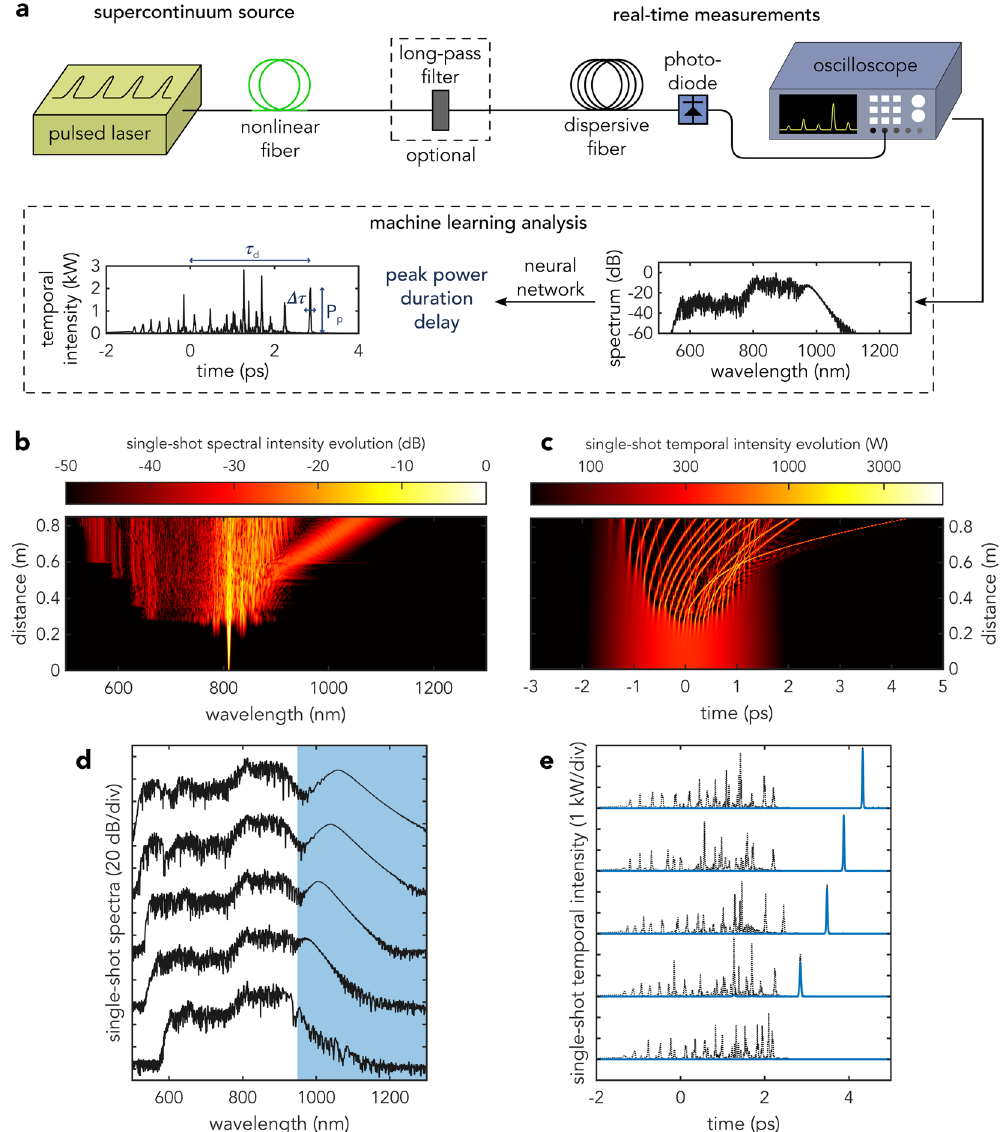
Figure 1. ( a ) Schematic of machine learning application to the analysis and prediction of rogue soliton temporal characteristics in supercontinuum generation based only on single-shot spectral measurements. ( b – e ) Dynamics of noisy supercontinuum generation. Single-shot spectral ( b ) and temporal ( c ) evolution where we see enhanced spectral broadening associated with the emergence of a rogue soliton. ( d , e ) show a selection of 5 random supercontinuum spectra and corresponding temporal intensity profiles in black. The blue curve in ( e ) shows the rogue soliton temporal intensity associated with the long-pass filtered spectral components (blue area) in ( d ) while the black dotted line shows the full time-domain